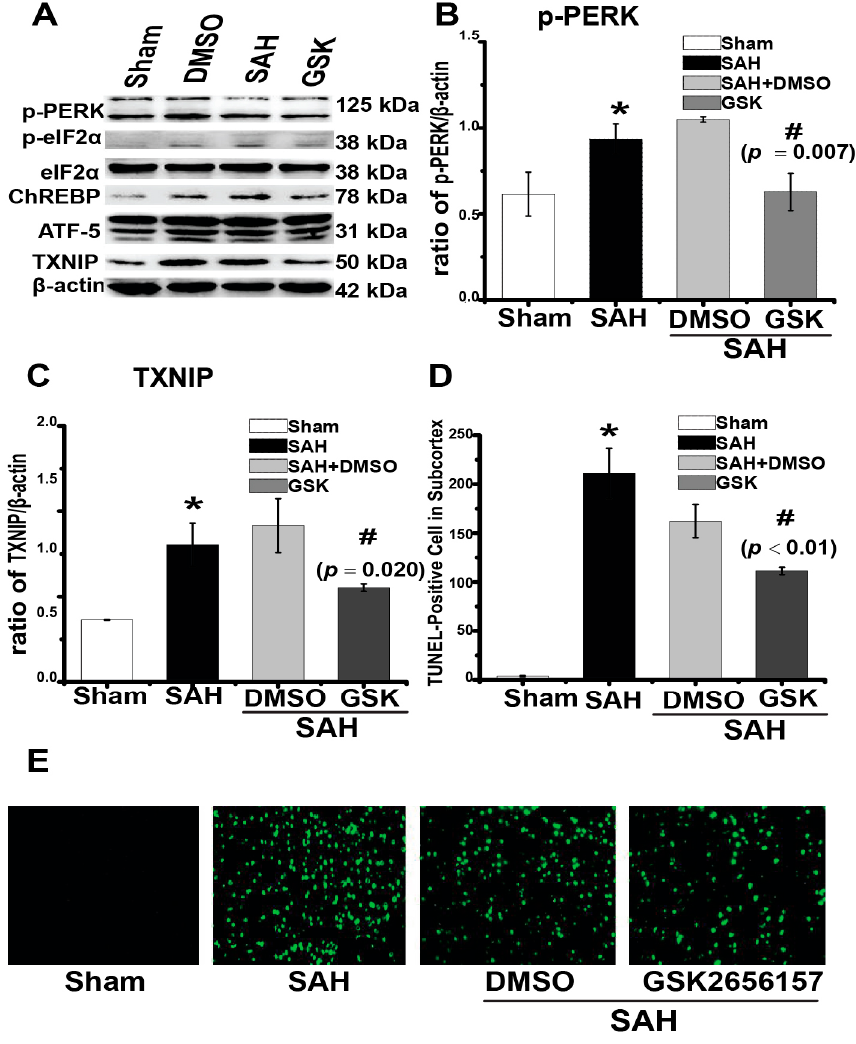
Figure 6. GSK2656157 treatment suppressed TXNIP expression and the number of TUNEL-positive cells. ( A – D , and Figure S3) Representative western blot of p-PERK, TXNIP, p-eIF2 α /eIF2 α , ATF-5, and ChREBP; ( D , E ) The number of TUNEL-positive cells decreased by the GSK2656157 treatment. Original magnification, × 400 ( n = 5, each group); scale bars: ( E ) = 60 µ m. * p < 0.05 vs. Sham, # p < 0.05 vs. SAH + DMSO.